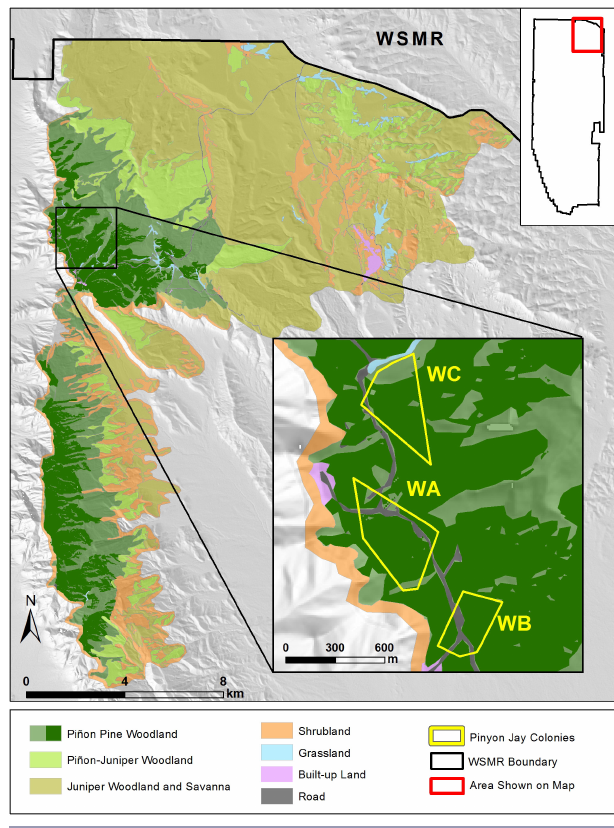
Fig. 6 . White Sands Missile Range Pinyon Jay ( Gymnorhinus cyanocephalus ) colony-scale predictive habitat model. Inset shows nesting colonies. Colony model is shown in bright green; other land cover is shown in muted colors. Geospatial and vegetation data from within Colonies WA and WB were used to create the colony-scale model. Colony WC area was used for validation. Of the WC Colony area, 75.9% fell within the predictive